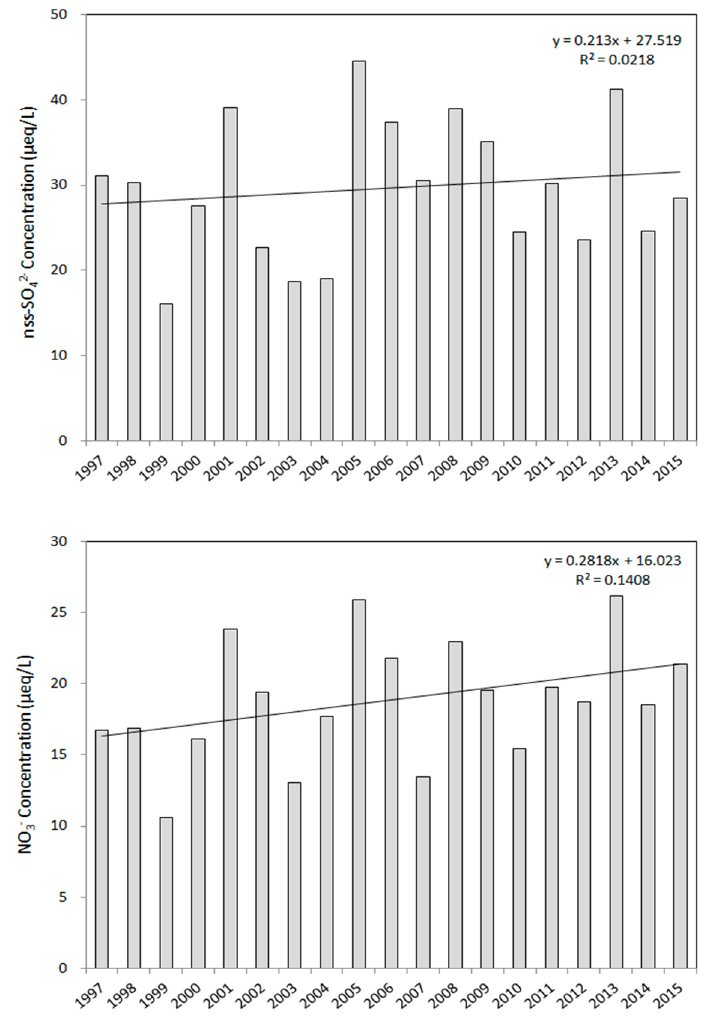
Figure 5. Long-term variations of nss-SO 42 − and NO 3 − in precipitation between 1997 and 2015. Table 4. Measured HCOOH T and CH 3 COOH T concentrations ( μ mol/L) in precipitation on Jeju Is- land and other areas.